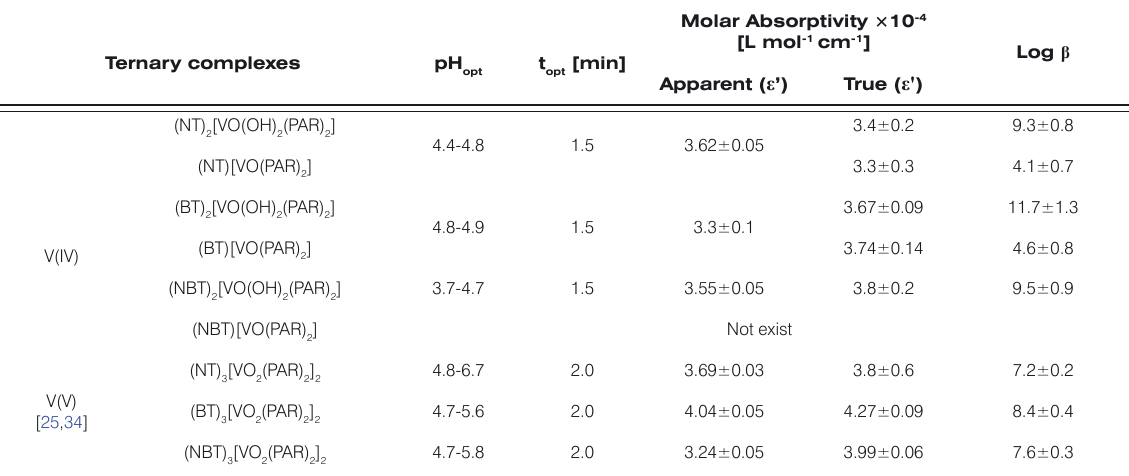
Table 1. Molar absorptivity coefficients, constants of association ( β ) and optimum pH and extraction time (t V(V) [25,34] with PAR and